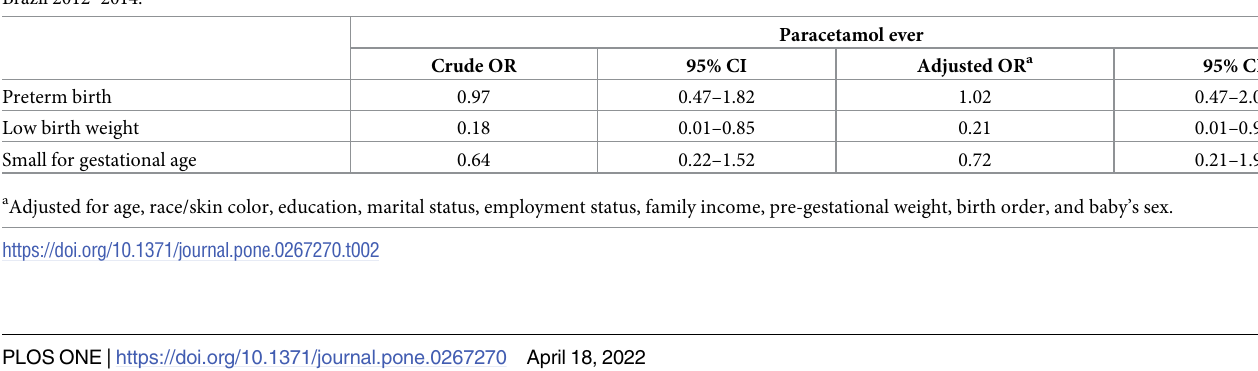
Table 2. Odds Ratios for preterm birth, low birth weight, and small for gestational age in women exposed to paracetamol during pregnancy. NISAMI Cohort Study, Brazil